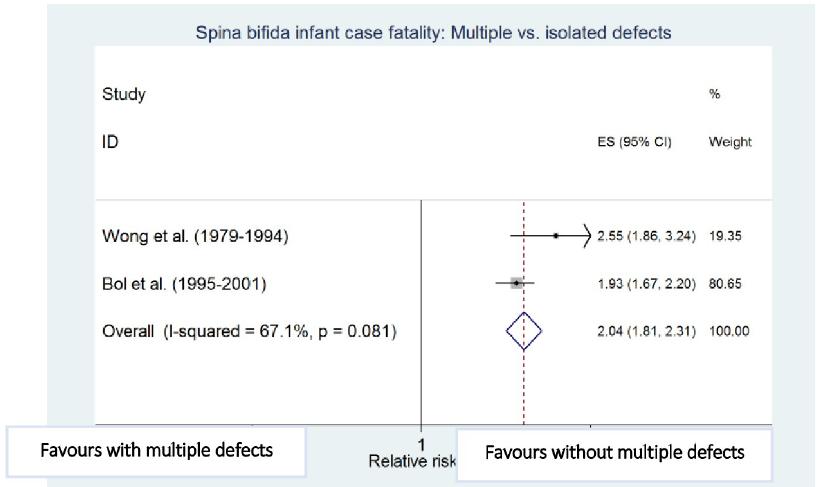
Fig 11. Presence of multiple anomalies. Spina bifida infant case fatality risk factors.